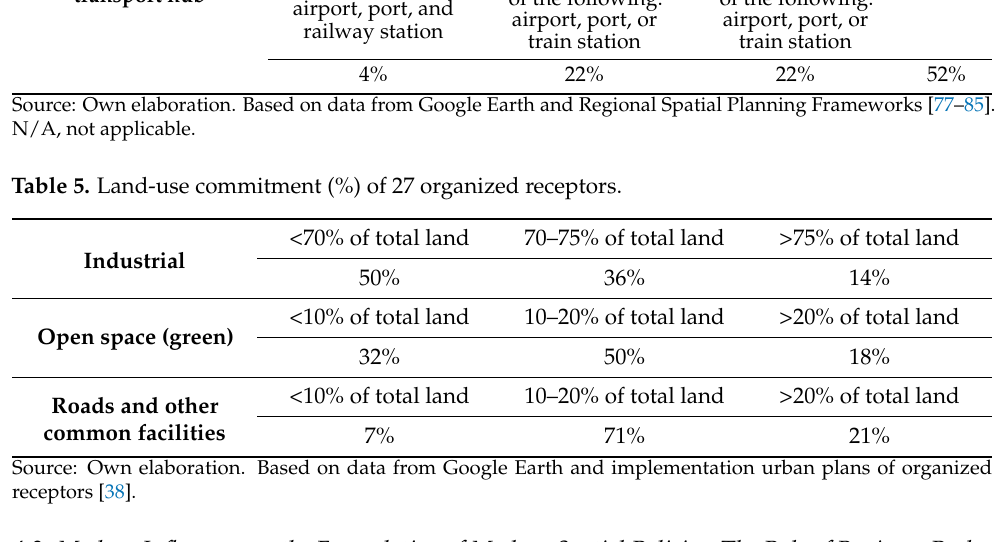
Table 4. Cont. Combined/multimodal transport hub